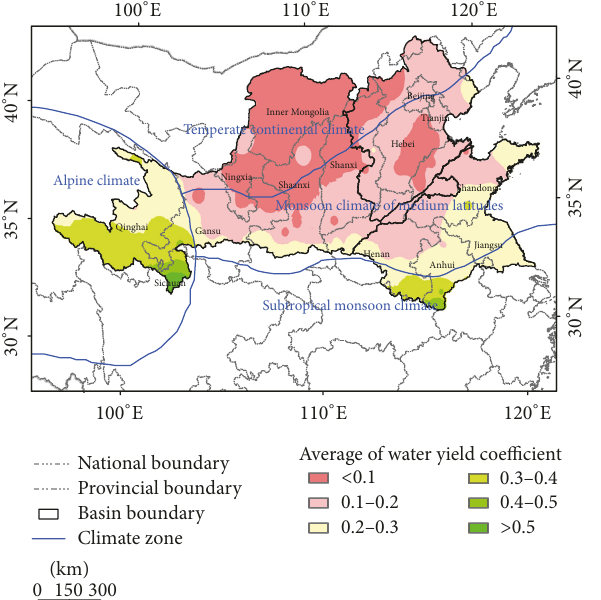
Figure 15: Multiyear average WYC spatial distribution from 1961 to 2011.